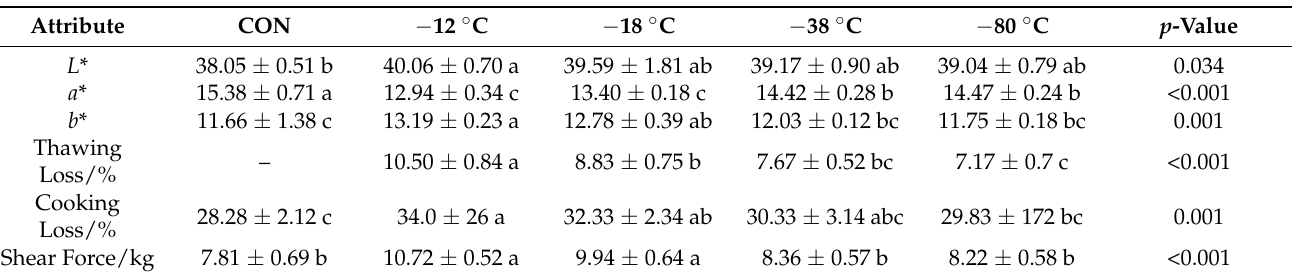
Table 1. Quality characteristics of beef in fresh control (CON) and different frozen treatments ( − 12 ◦